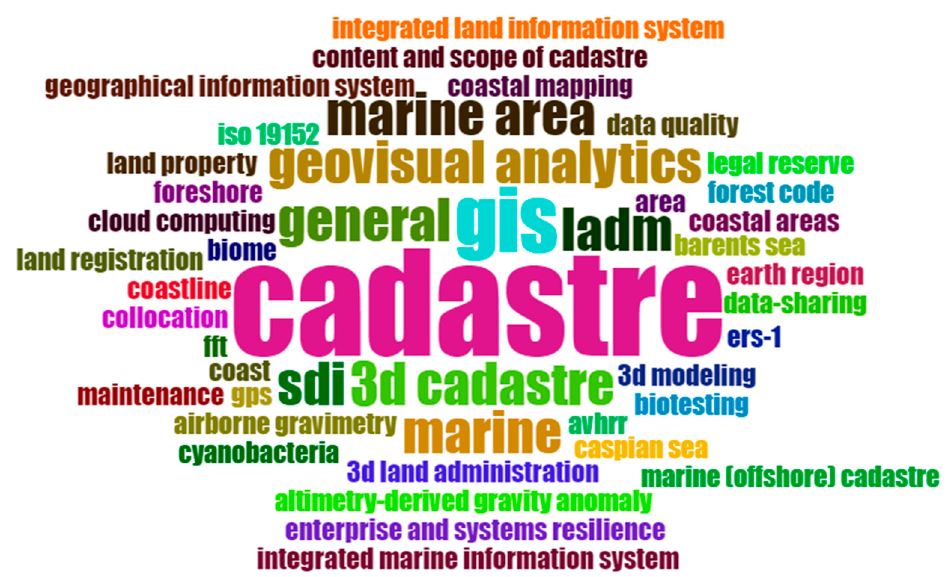
Figure 7. Word cloud of MC keywords.